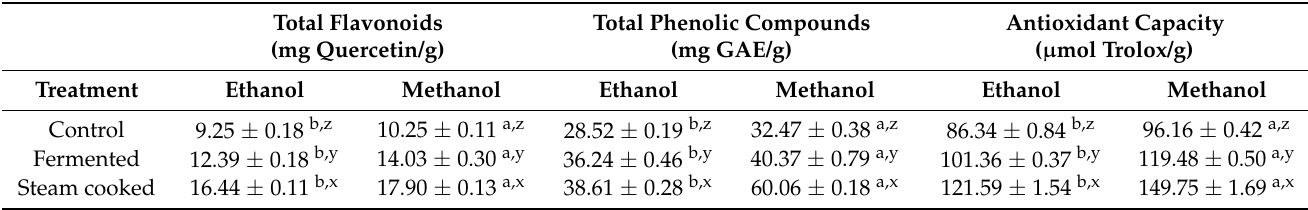
Table 3. Effect of pretreatment on the antioxidant compounds and capacity of garlic peel extracts † .